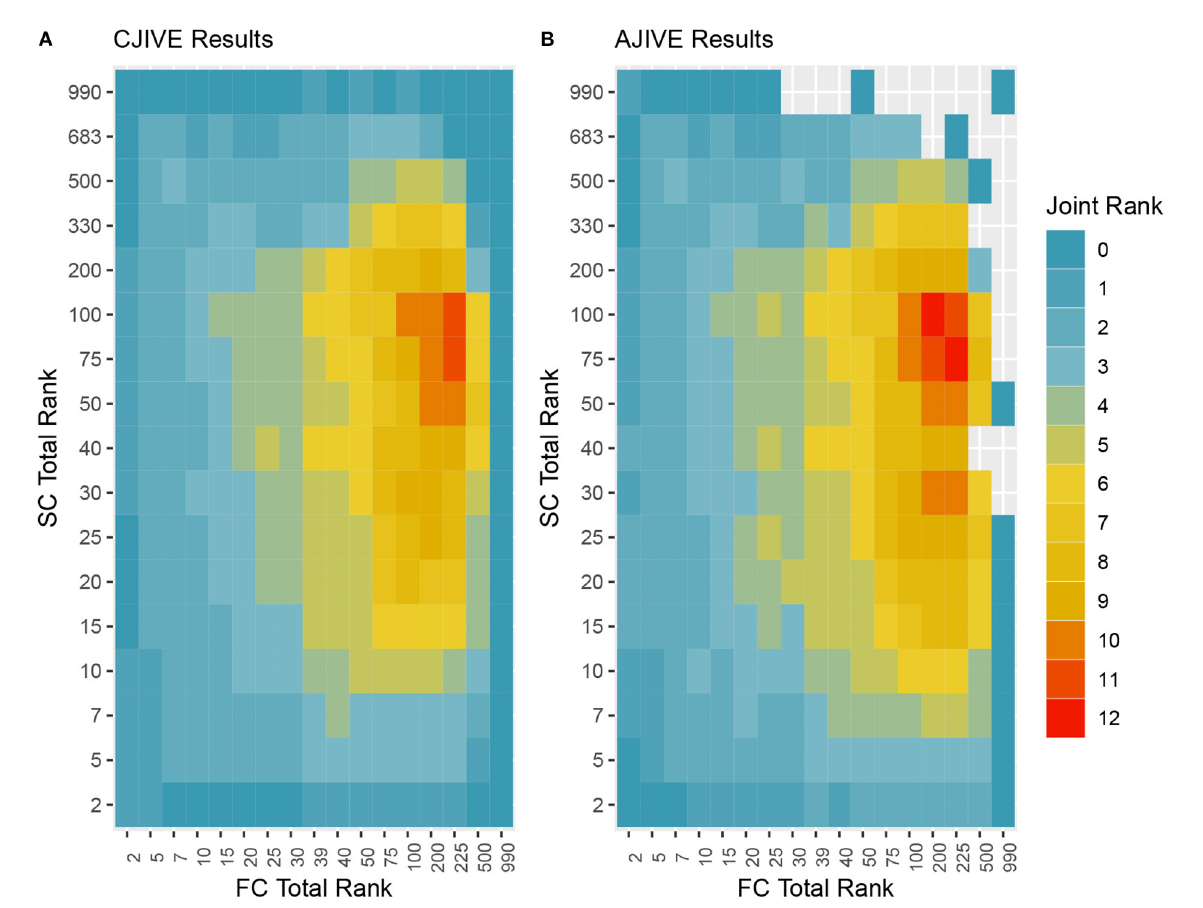
FIGURE5 Joint ranks chosen by (A) CJIVE and (B) AJIVE. Gray boxes show when a JIVE implementation produced an